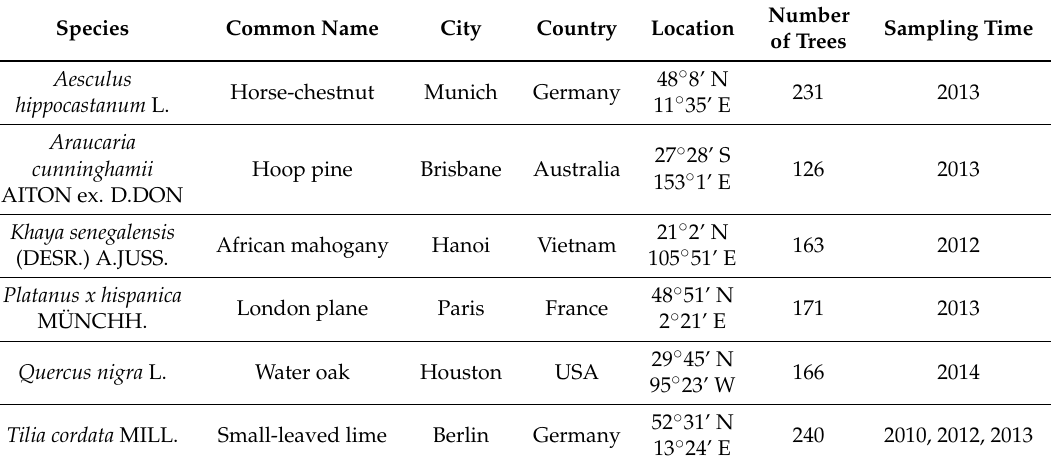
Table 1. Sample description of tree species, within the cities, geography (latitude, longitude), sampling size, and time. Only trees in an urban environment are